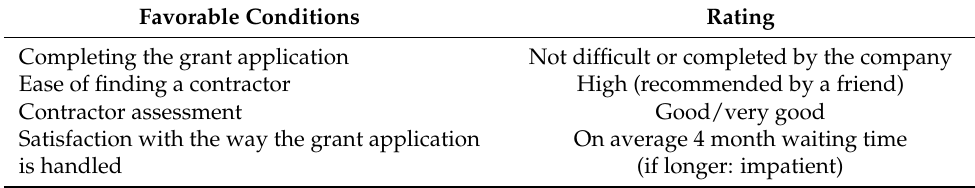
Table 5. Conditions favoring the investment ( n =